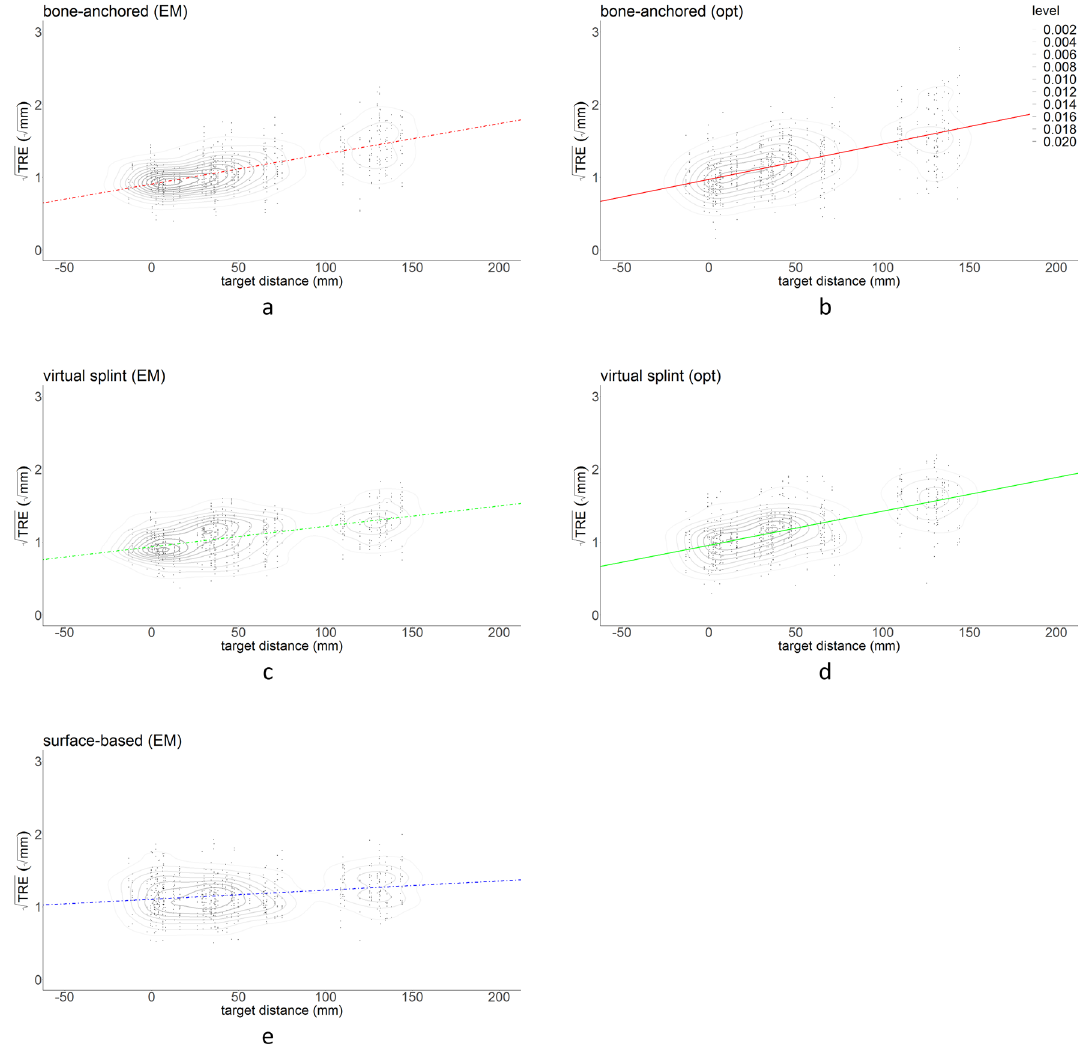
Figure 6. Combined scatter plots and kernel density estimates for each registration method and tracking technique, for all data points. From the kernel density estimate levels, the concentration of measurements is visualized. The corresponding regression line from Fig. 3 is superimposed on the scatter